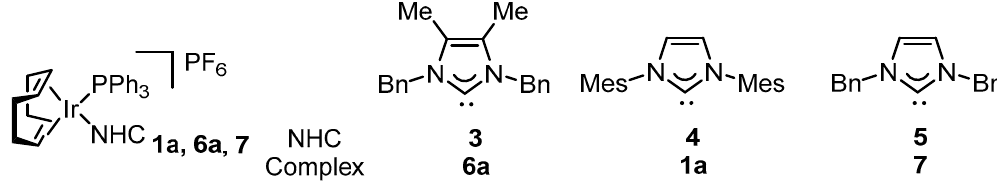
Figure 3. Iridium(I) complexes with varying NHC ligands to probe their steric and electronic influence.